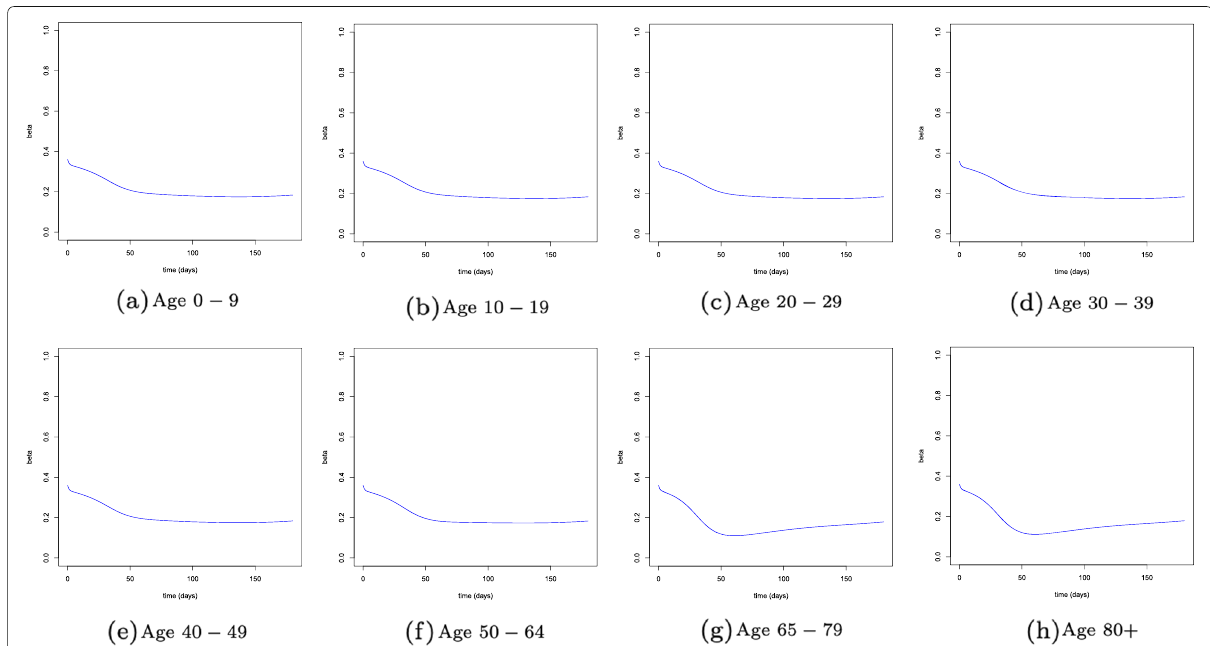
Fig. 2 Contact rate by age group over time. Note: This figure displays the evolution over time of the contact rates of individuals belonging to different age groups. Such dynamics reflect the differences in the intensity of the behavioral responses of these subjects. In particular, older individuals—namely those who are more likely to suffer from the most severe consequences of the disease—tend to reduce their contact rates more substantially in response to an increase in the number of